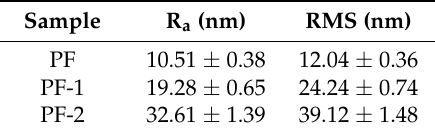
Table 3. Surface roughness of PET